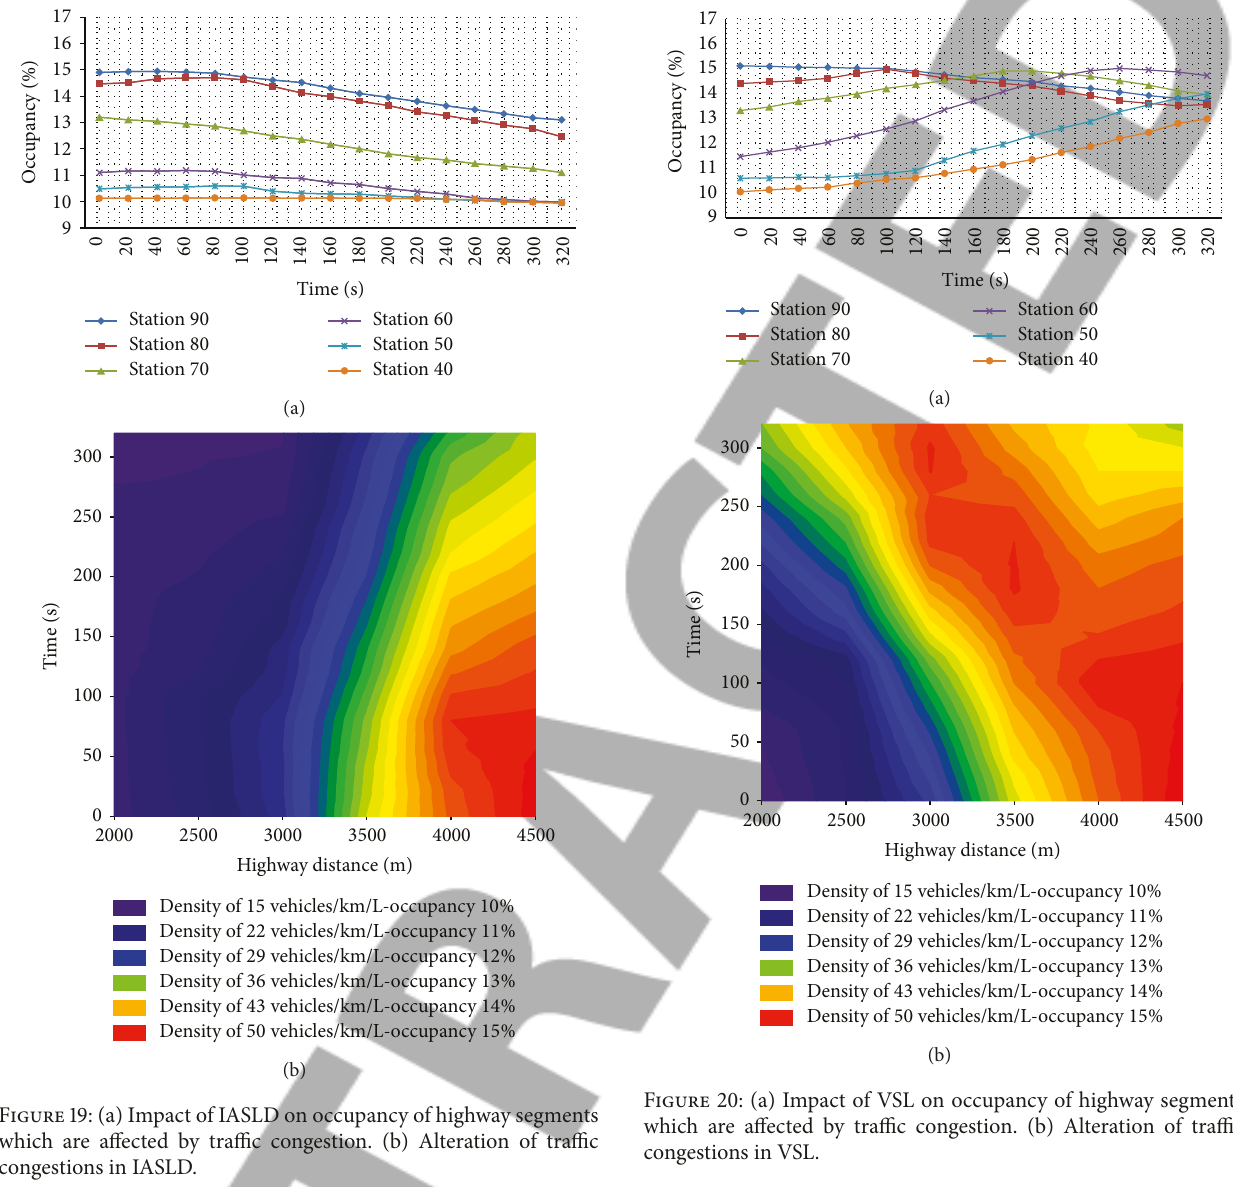
Figure 19: (a) Impact of IASLD on occupancy of highway segments which are affected by traffic congestion. (b) Alteration of traffic congestions in IASLD.